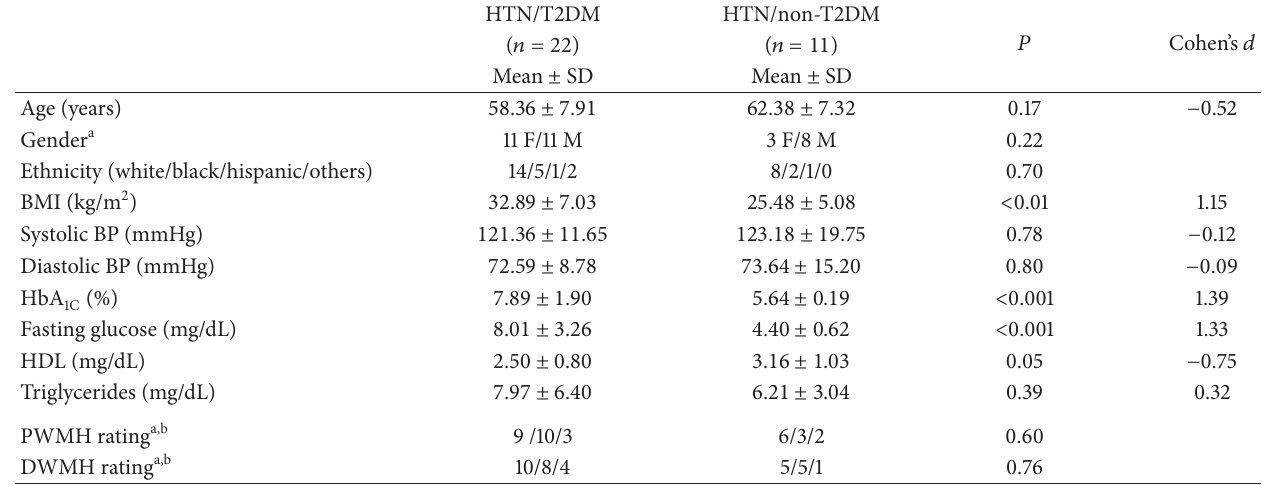
Table 3: Demographic and endocrine data: hypertensive/T2DM versus hypertensive/non-T2DM.